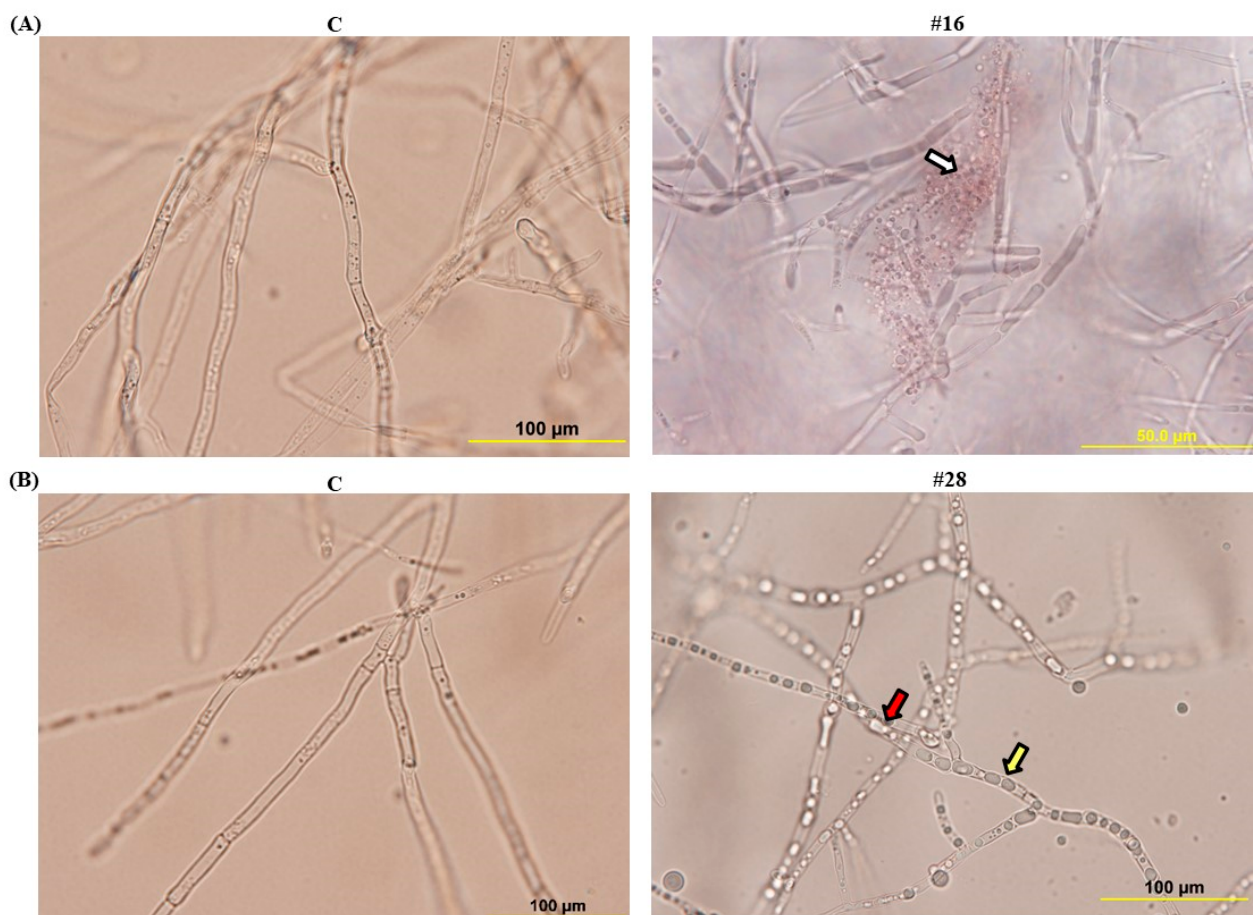
Figure 4. Effect of the BCAs on hyphae and cytoplasm of Fusarium solani . Abnormalities observed in the hyphal morphology including septum formation and cytoplasmic contents of F. solani , following exposure to ( A ) isolate #16 on CCB; or ( B ) filter-sterilized crude culture filtrate of isolate #28 on FMEB, compared to their corresponding control (C). White arrow indicates cytoplasmic lysis. Yellow and red arrows indicate hyphal non-septate formation and cytoplasmic coagulation, respectively. Light microscopy images were taken at 1000X magnification. Isolates #16 and #28 represent Streptomyces polychromogenes UAE2 (BCA1) and Streptomyces coeruleoprunus UAE1 (BCA2), respectively. BCA, biological control agent; CCB, colloidal chitin broth; FMEB, fish meal extract broth.